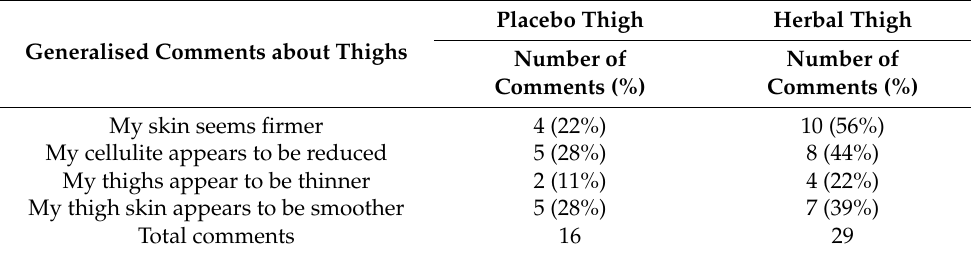
Table 3. Summary of 45 spontaneous free-text comments extracted from participant diaries entered during the 12-week treatment. Translated by sense rather than verbatum.